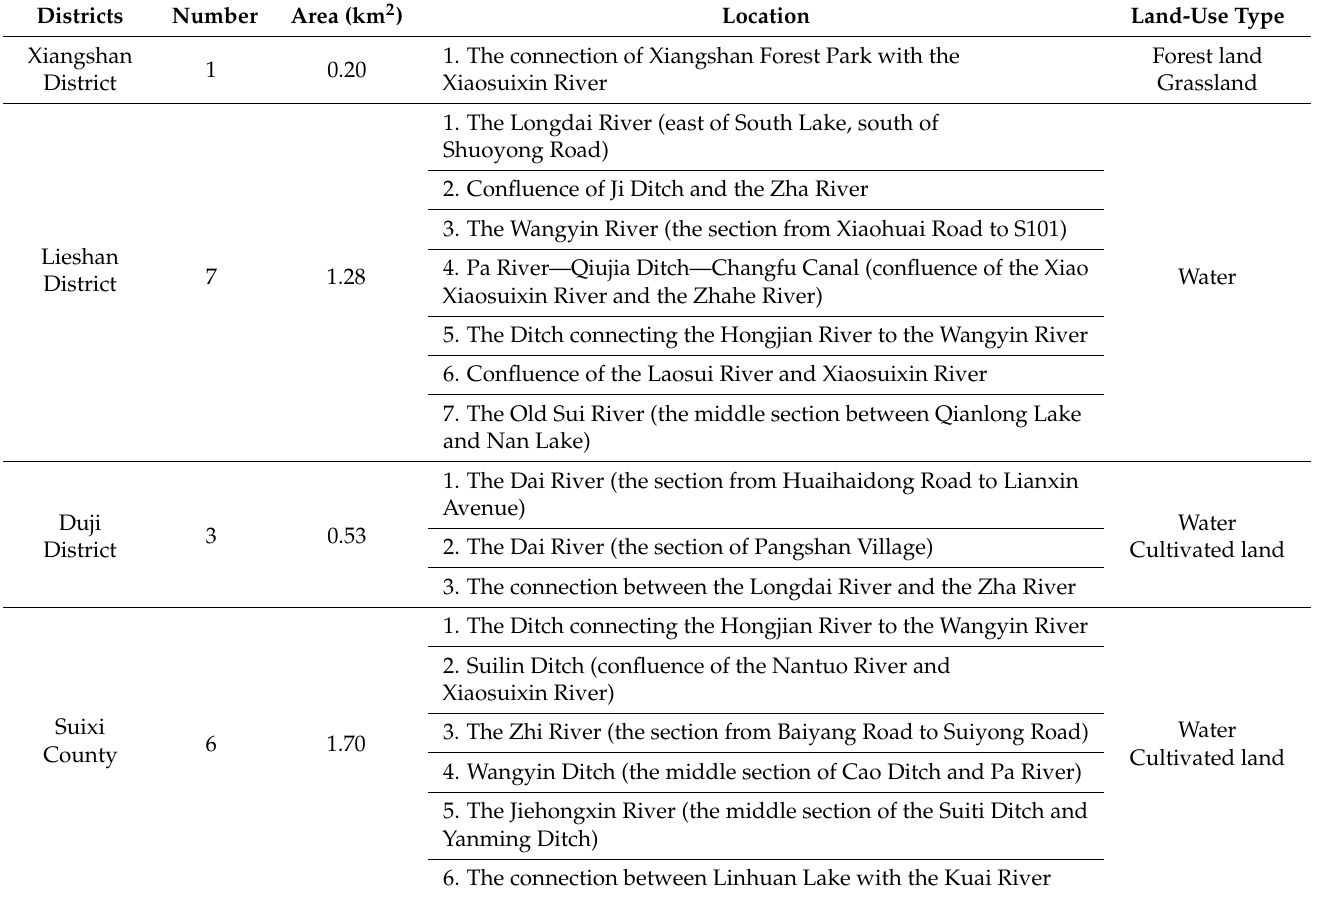
Table 4. Distribution of ecological pinch points in Huaibei